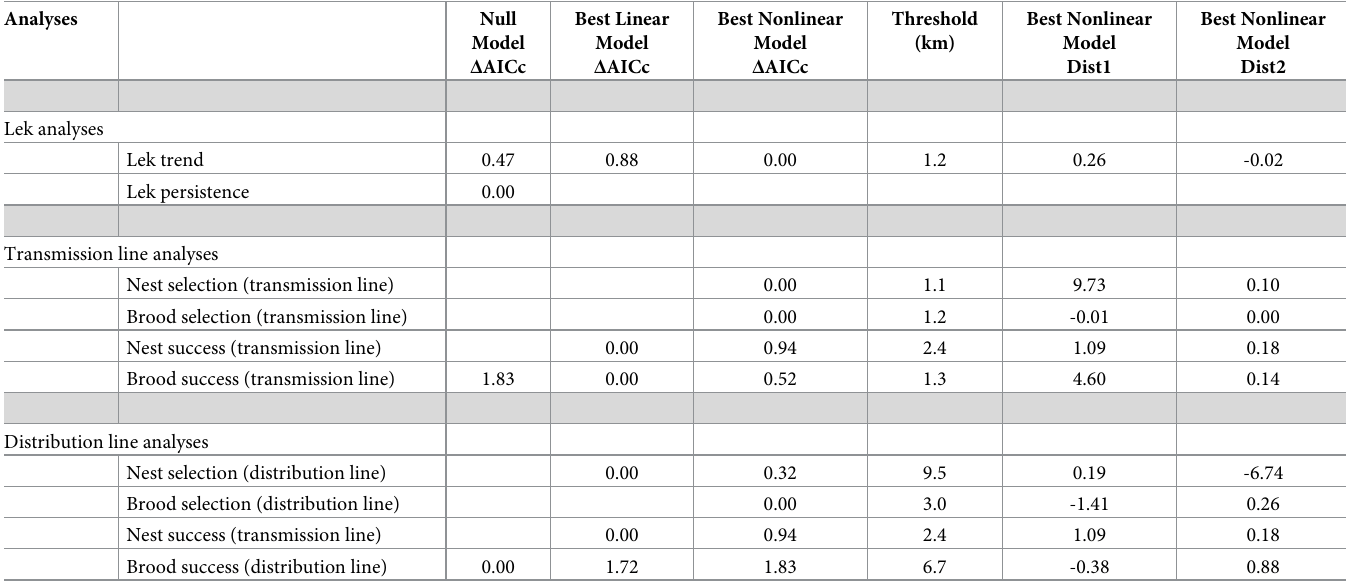
Table 2. Preponderance of evidence Table. Delta AIC scores corrected for small sample sizes for the best-fit null, linear, and nonlinear model for each analyses.